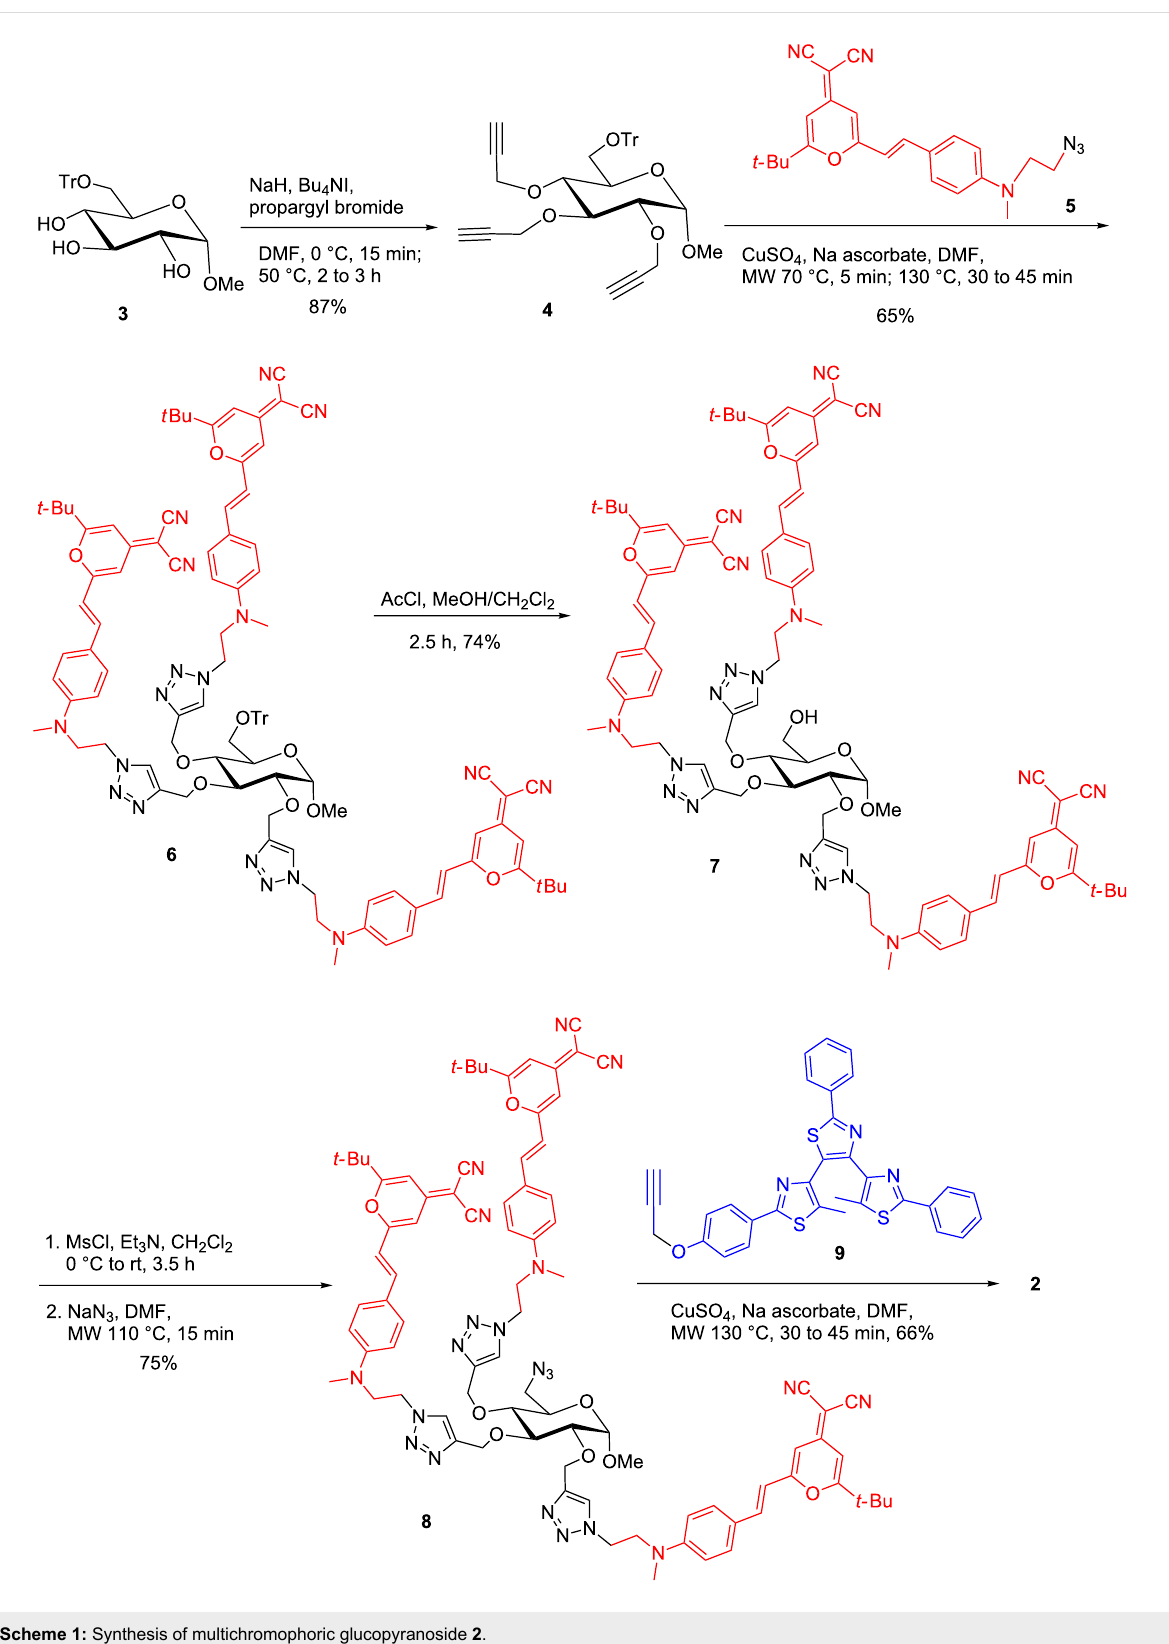
Scheme 1: Synthesis of multichromophoric glucopyranoside 2